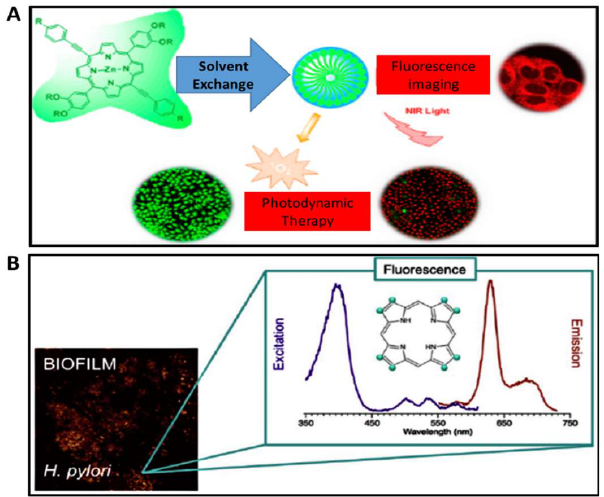
Figure 4. ( a ) Photodynamic therapy (PDT) application [45] and ( b ) fluorescence imaging capabilities of porphyrins [33].